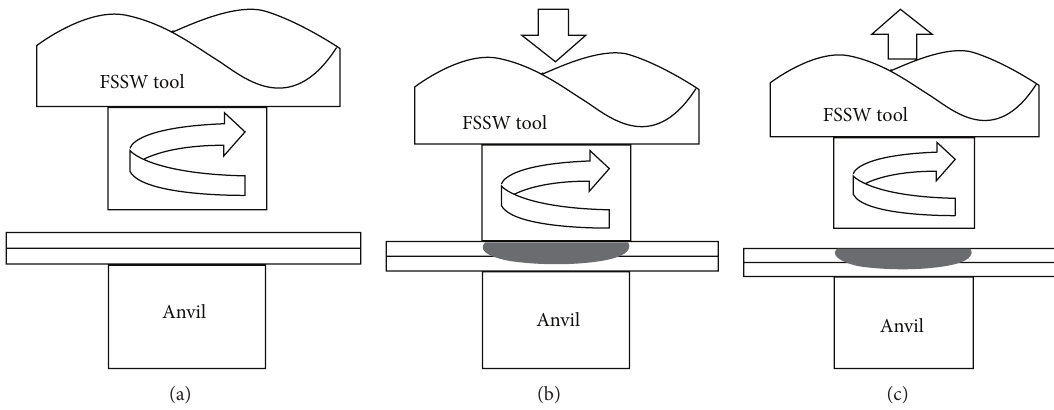
Figure 3: Illustration of the pinless FSSW process: (a) plunging, (b) stirring, and (c) retracting [12].